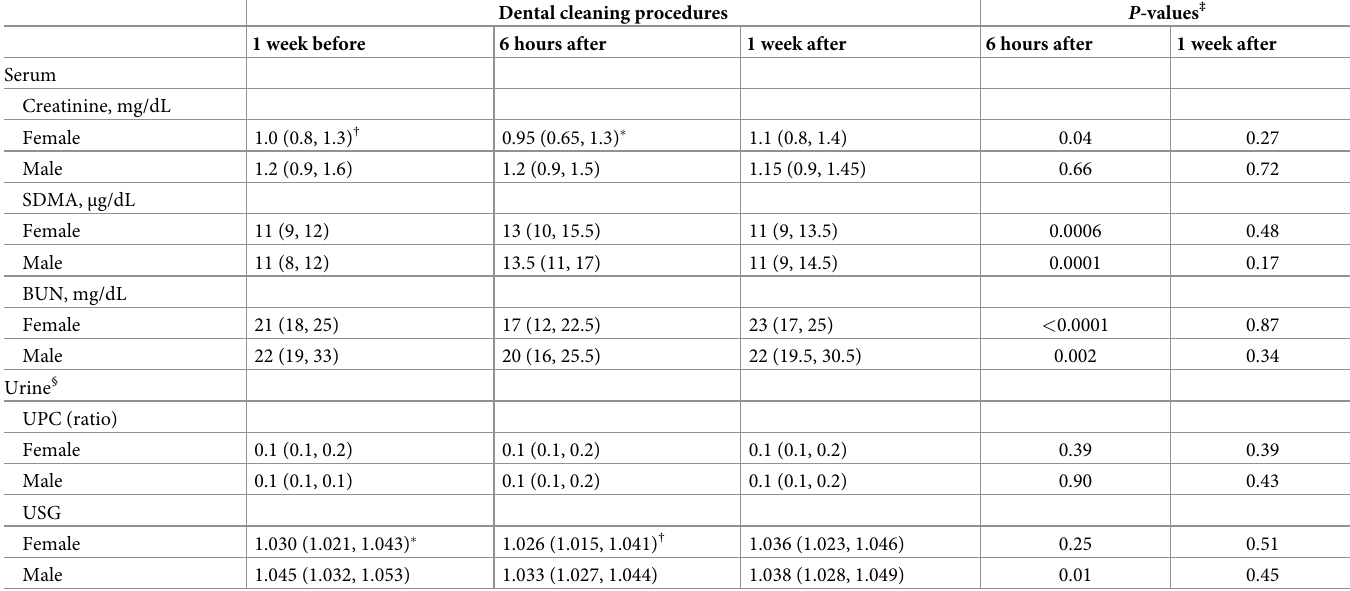
Table 2. Serum and urine kidney function biomarkers before and after general anesthesia and dental cleaning procedures in cats and dogs with periodontal disease stratified by sex (n = 62) � . Dental cleaning procedures P -values